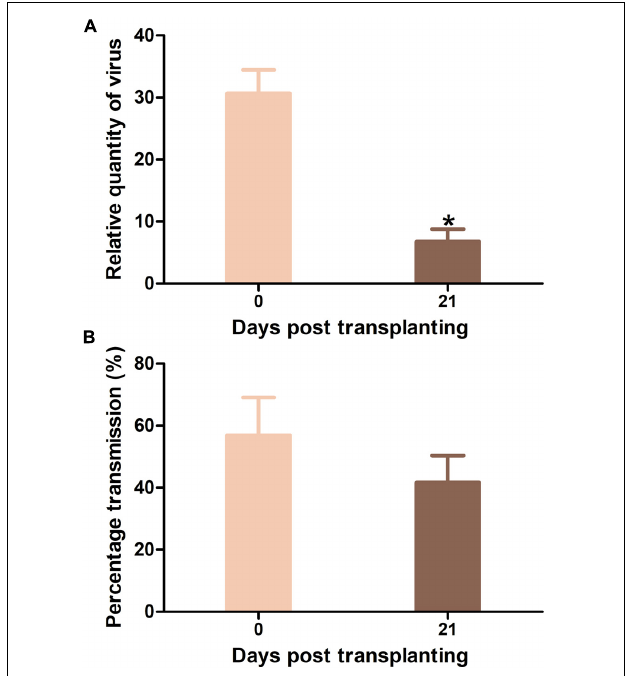
FIGURE 7 | Tomato yellow leaf curl virus (TYLCV) quantity in whiteflies and virus transmission efficiency by whiteflies when Hezou903 plants inoculated at 0 and 21 DPT were used as the source of inoculum. (A) TYLCV quantity in whiteflies; (B) TYLCV transmission efficiency by whiteflies. Values are means ± SEM ( n = 4 for panel (A) ; n = 3 and each replicate contains 8–9 test plants for panel (B) . *Above columns indicate significant differences (independent t -test, p < 0.05).